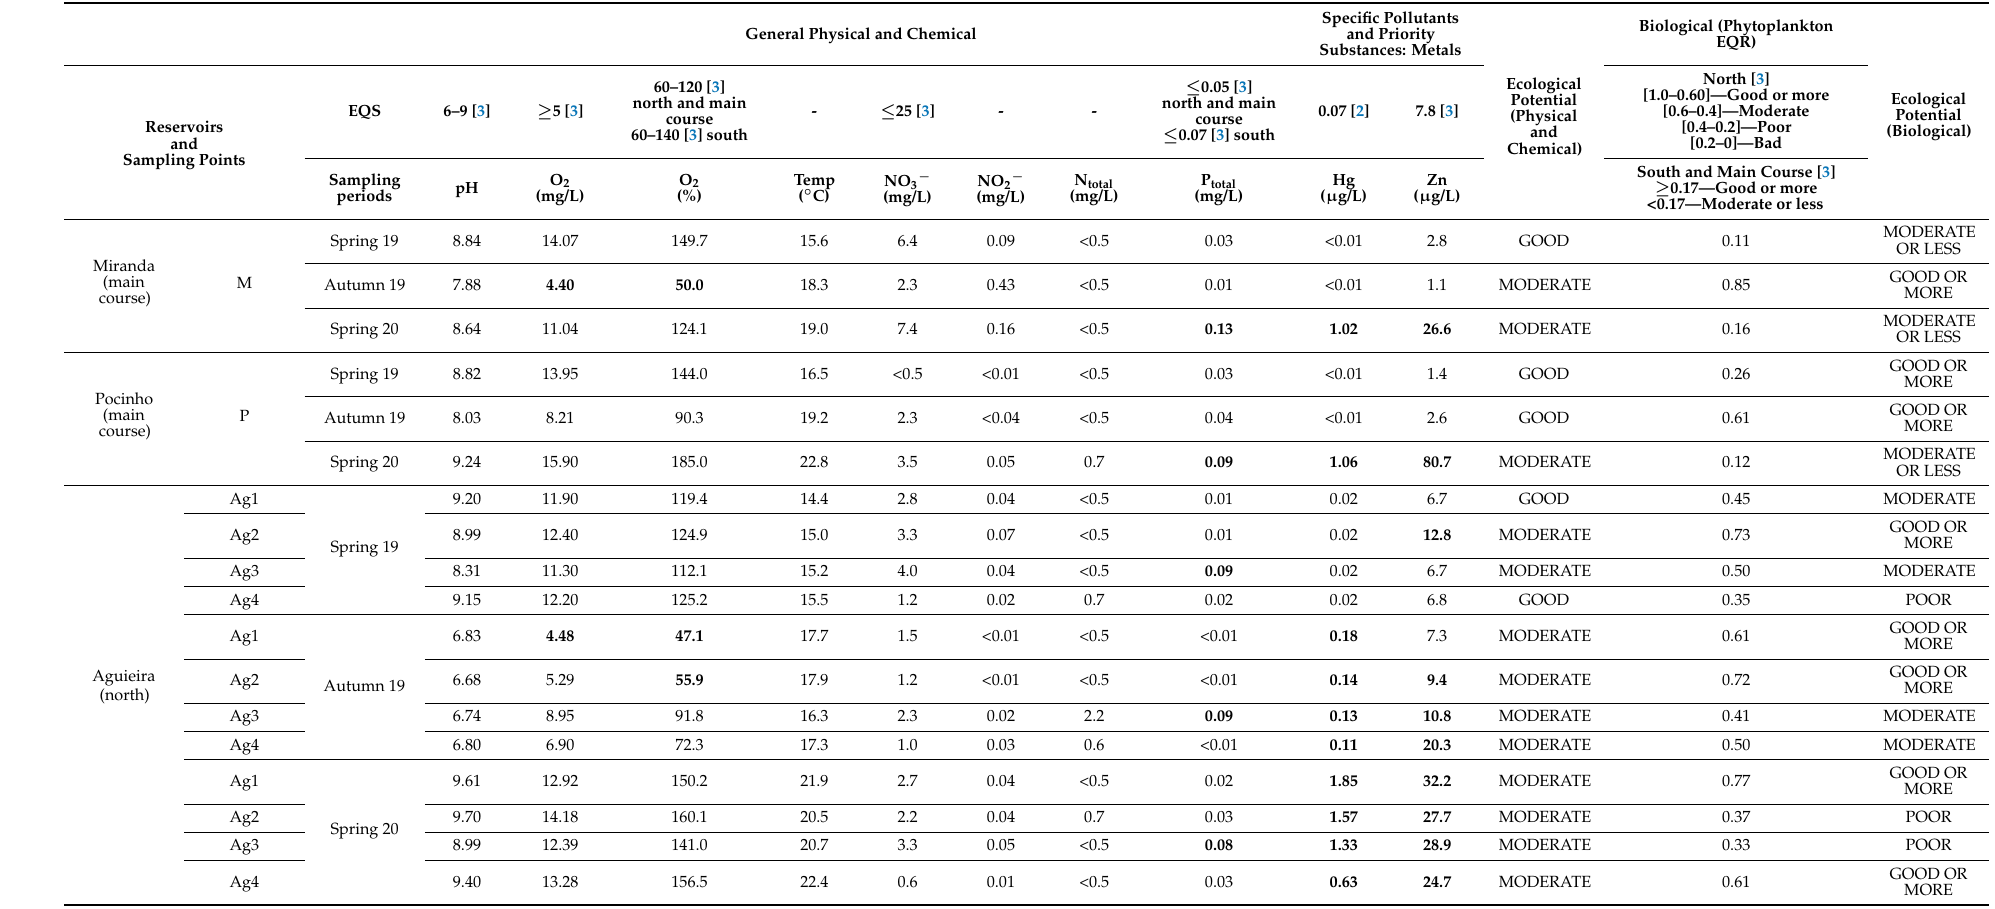
Table 1. Results of the pH, dissolved oxygen (mg/L and %) and temperature, measured in situ, and nitrates (NO 3 − ), nitrites (NO 2 − ), total Kjeldahl nitrogen (N total ), total phosphorus (P total ), specific pollutants and priority substances concentrations ( µ g/L) with values above the environmental quality standards (EQS). For Portugal northern, main course and southern reservoirs established by WFD, the ecological potential and threshold values [for physical, chemical and biological (expressed in Ecological Quality Ratio—EQR) parameters], according WFD metrics, are presented. Sampling sites: Miranda—M, Pocinho—P, Aguieira—Ag1, Ag2, Ag3, Ag4 and Alqueva—Al1, Al2, Al3, Al4 and Al5; Sampling periods: Spring of 2019 (Spr19), Autumn of 2019 (Aut19) and Spring of 2020 (Spr20). Bold values stand for values outside the established